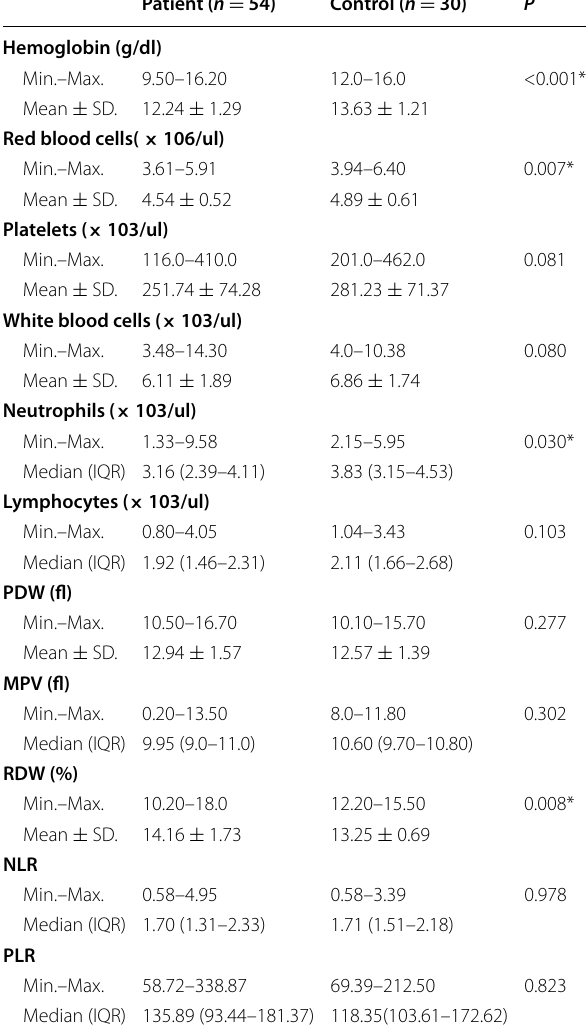
Table 1 Comparison between the two studied groups according to blood cell count and inflammatory markers